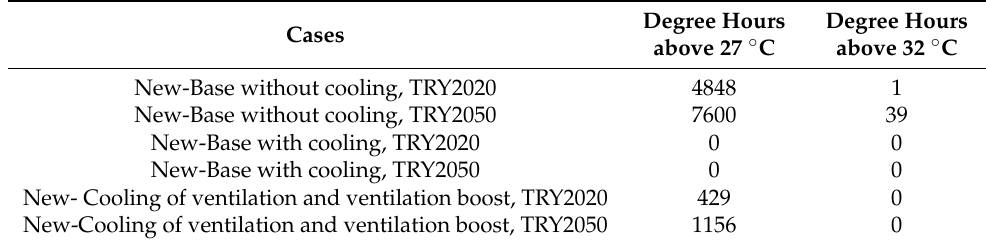
Table 9. The annual degree hours above 27 ◦ C and 32 ◦ C, Comparison of the cases with different cooling systems under the current and future